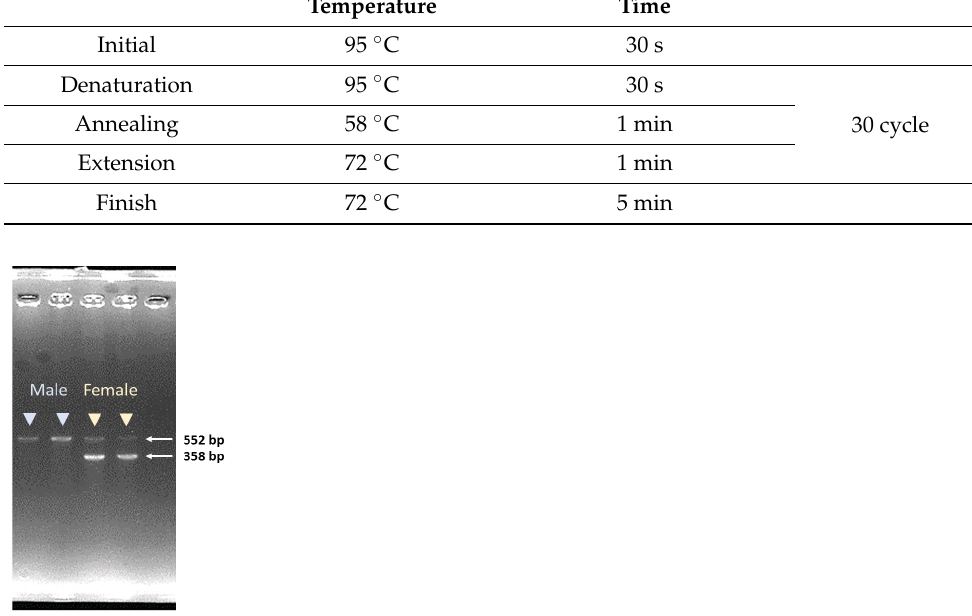
Figure 3. Sex identification for chick fetus using PCR. One single band at 552 bp indicated a male fetus and two bands at 552 bp and 358 bp indicated a female fetus.